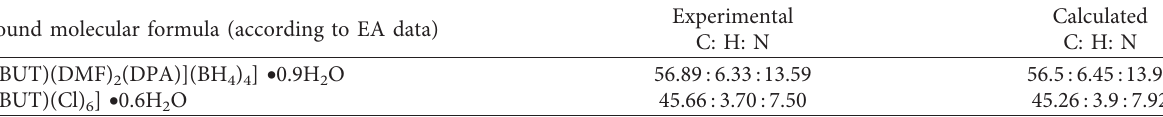
Table 3: Experimental and calculated elemental analysis of complexes. Experimental Calculated Compound molecular formula (according to EA data)